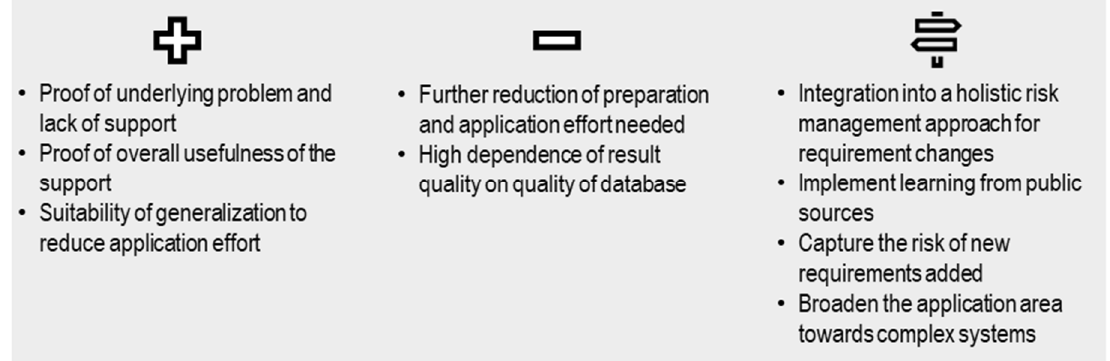
Figure 12. Evaluation results and future research directions.